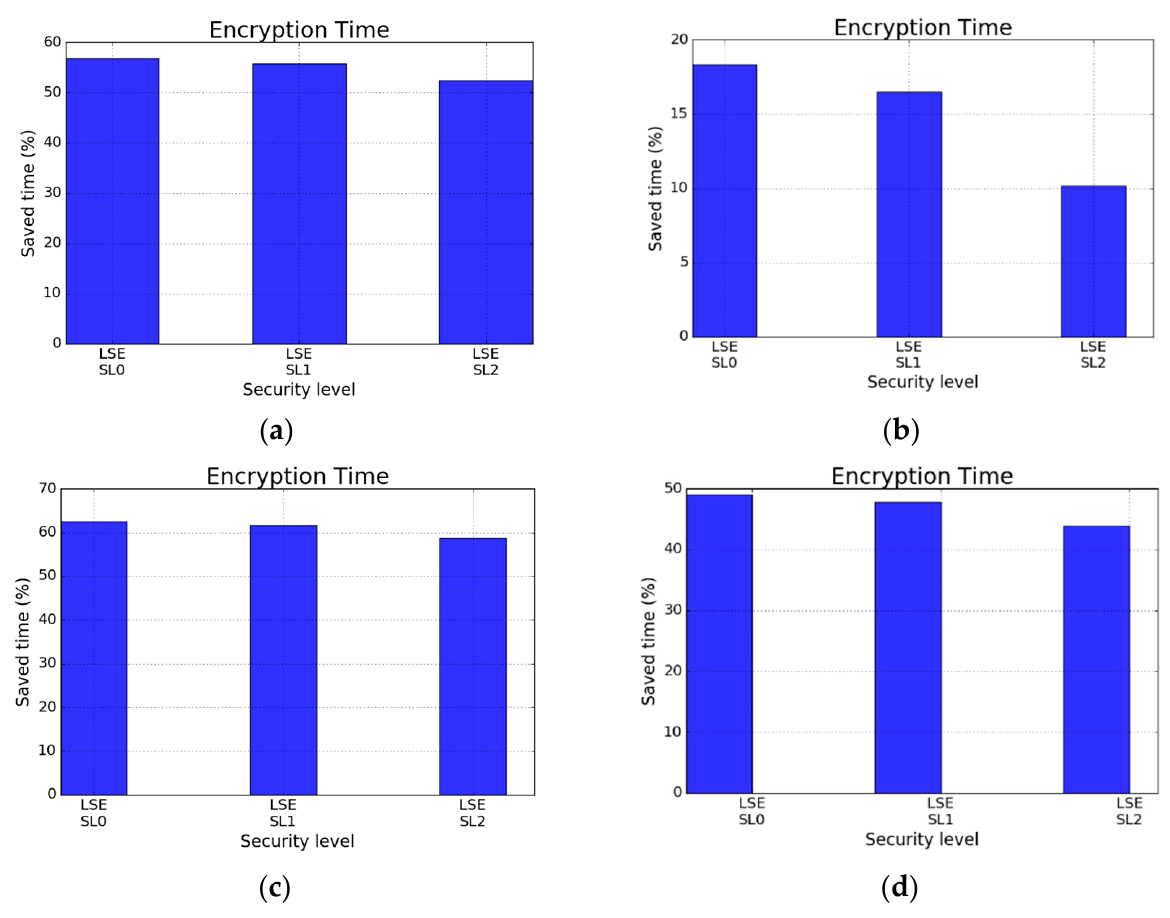
Figure 10. Saved time (%) with respect to ( a ) two-region encryption approach, ( b ) two-region encryption/compression approach, ( c ) Naïve encryption approach, and ( d ) Naïve encryption/compression approach.